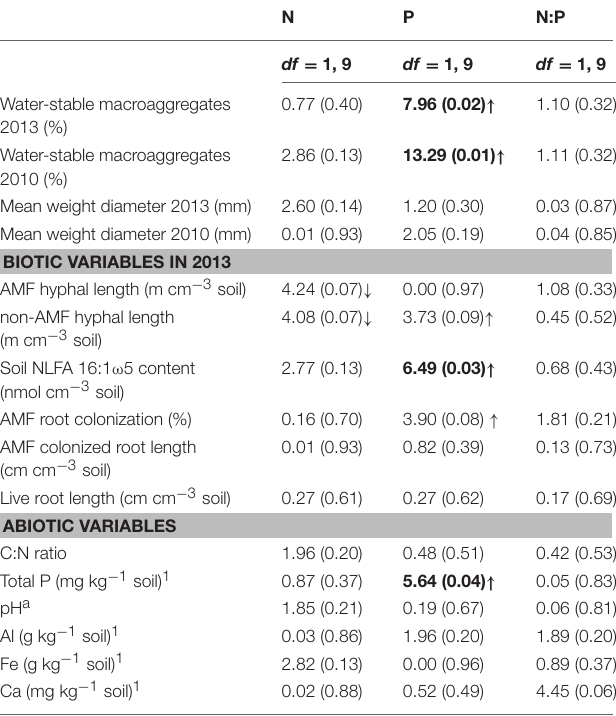
TABLE 2 | Results of simple linear regression analyses of biotic and abiotic predictor variables with the amount of water-stable macroaggregates (based on linear mixed-effects models including Block and Plot as random